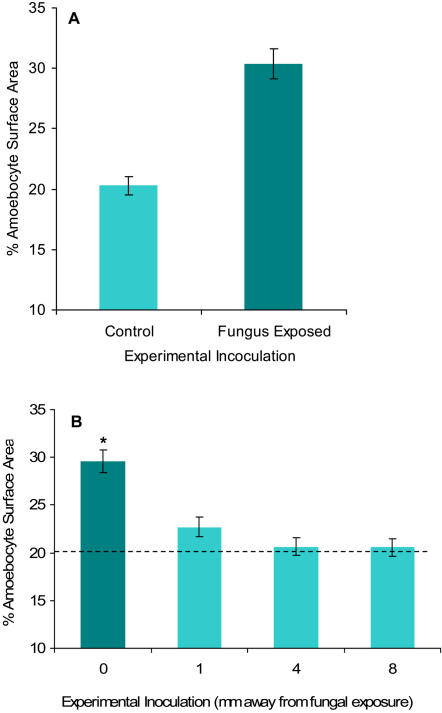
Quantitative analysis of amoebocytes in mesoglea of sea fans experimentally exposed to Aspergillus sydowii.A) Increase in amoebocytes in sea fans exposed to fungal hyphae, n = 14, X
2 = 41.85, p<0.0001. B) Fine spatial analysis of amoebocyte surface area at point of fungus exposure and 1, 4, and 8 mm away. Dashed line indicated control or basal % amoebocyte surface area. Data presented are mean±s.e.m, n = 8, F = 18.95, p = 0.015. Asterisk denotes significant differences at p<0.05.